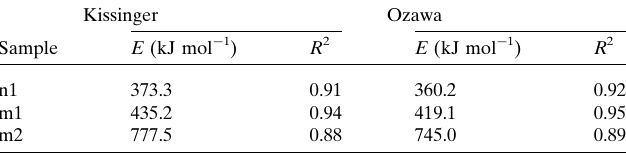
Table 1 The activation energy, enthalpy, entropy and Gibbs activation energy